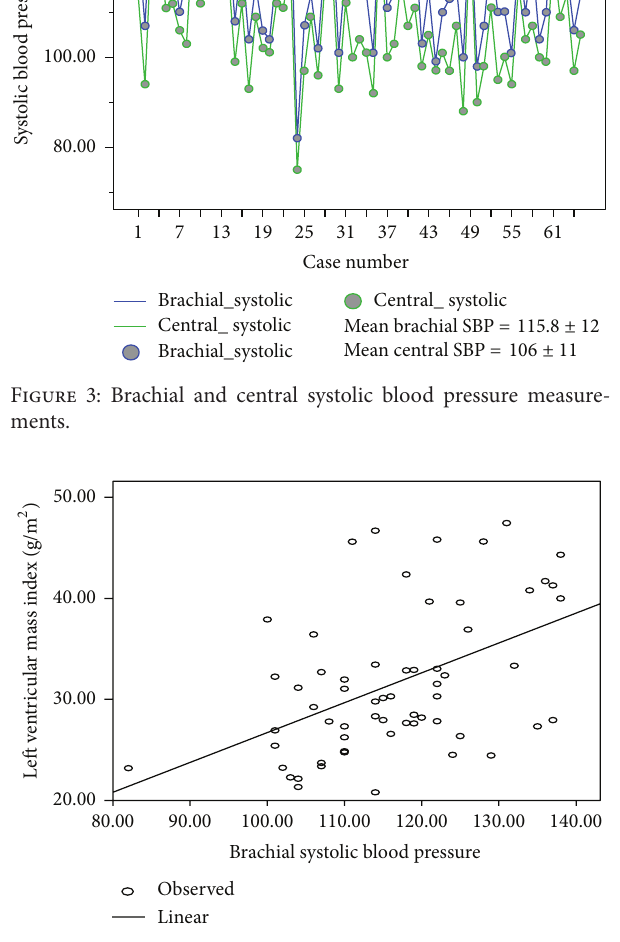
Figure 4: Correlation between LV mass index (kg/m 2 ) and brachial systolic blood pressure.